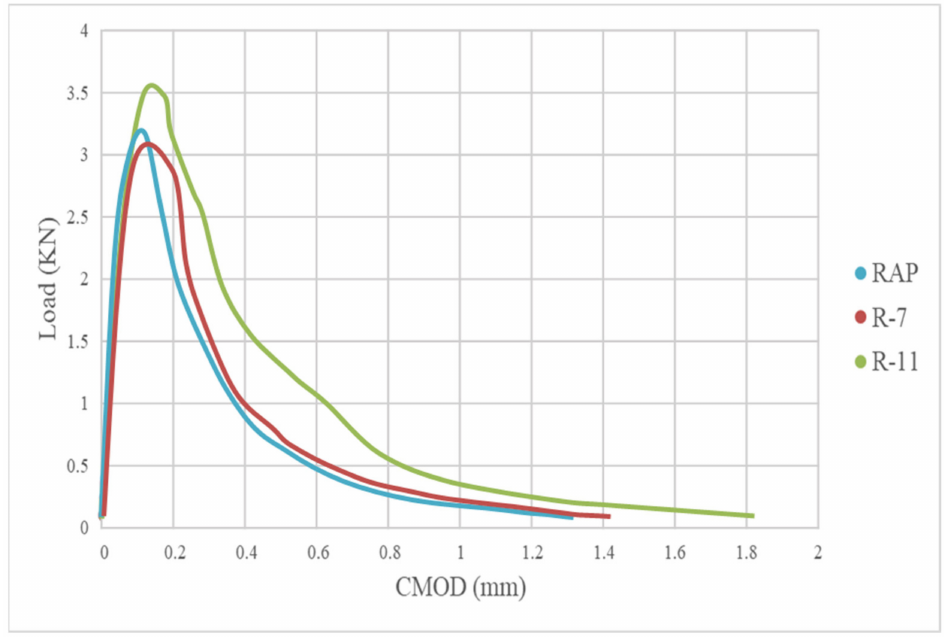
Figure 8. Load vs. CMOD of RAP specimens without additive, 7% A1 and 11% A2.